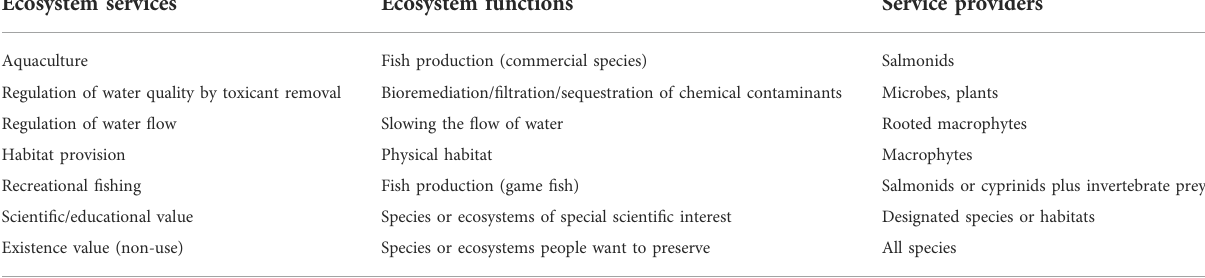
TABLE 2 Illustrative ecosystem functions and service providers for biotic ecosystem services listed in Table 1. Ecosystem